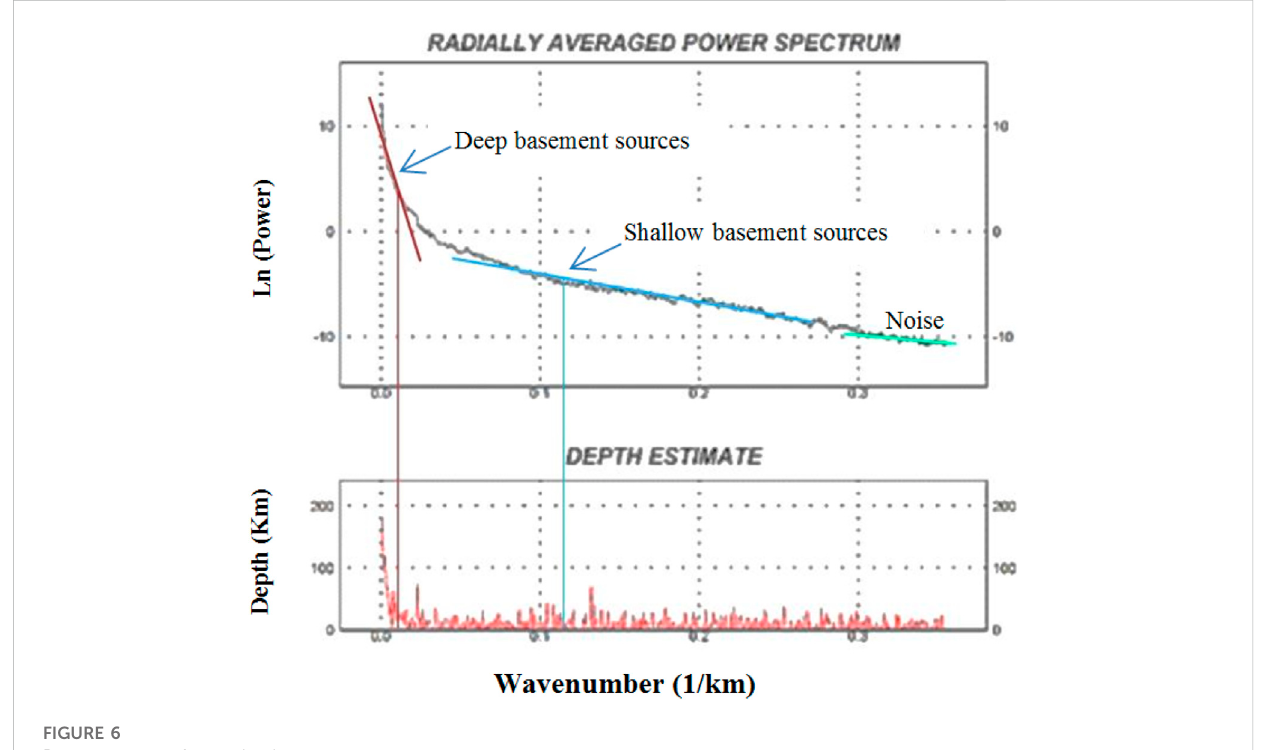
FIGURE 6 Power spectrum for gravity